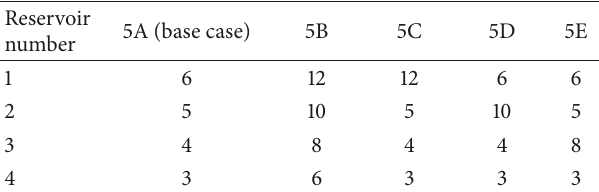
Table 5: Five cases with different initial formation pressures (MPa). Reservoir